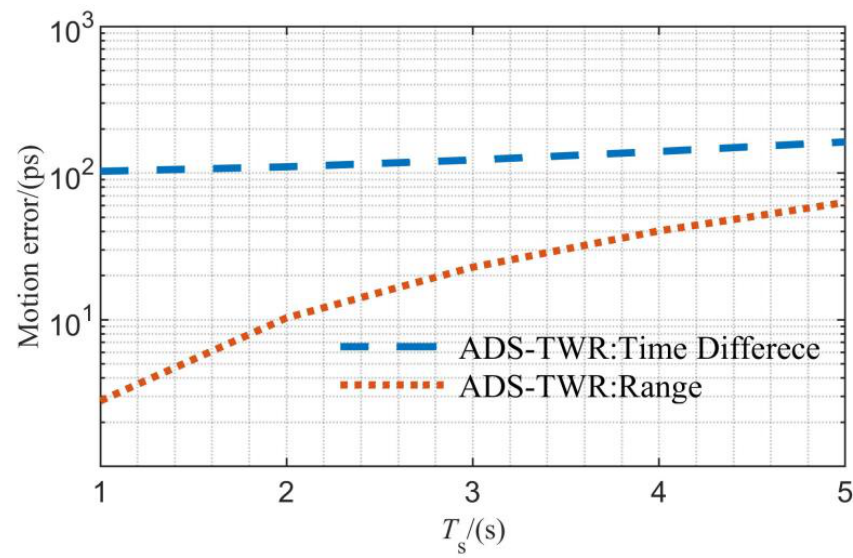
The simulation of the joint measurement error caused by satellite motion is shown in Figure 5. For the convenience of comparison, the range measurement results are normalized to time. As shown in this figure, the motion error in the time difference measurement is about 100 ps larger than that in the range measurement. However, the time difference error in the joint measurement remains at a hundred-picosecond level, which can meet the requirements of general microsatellite formations.